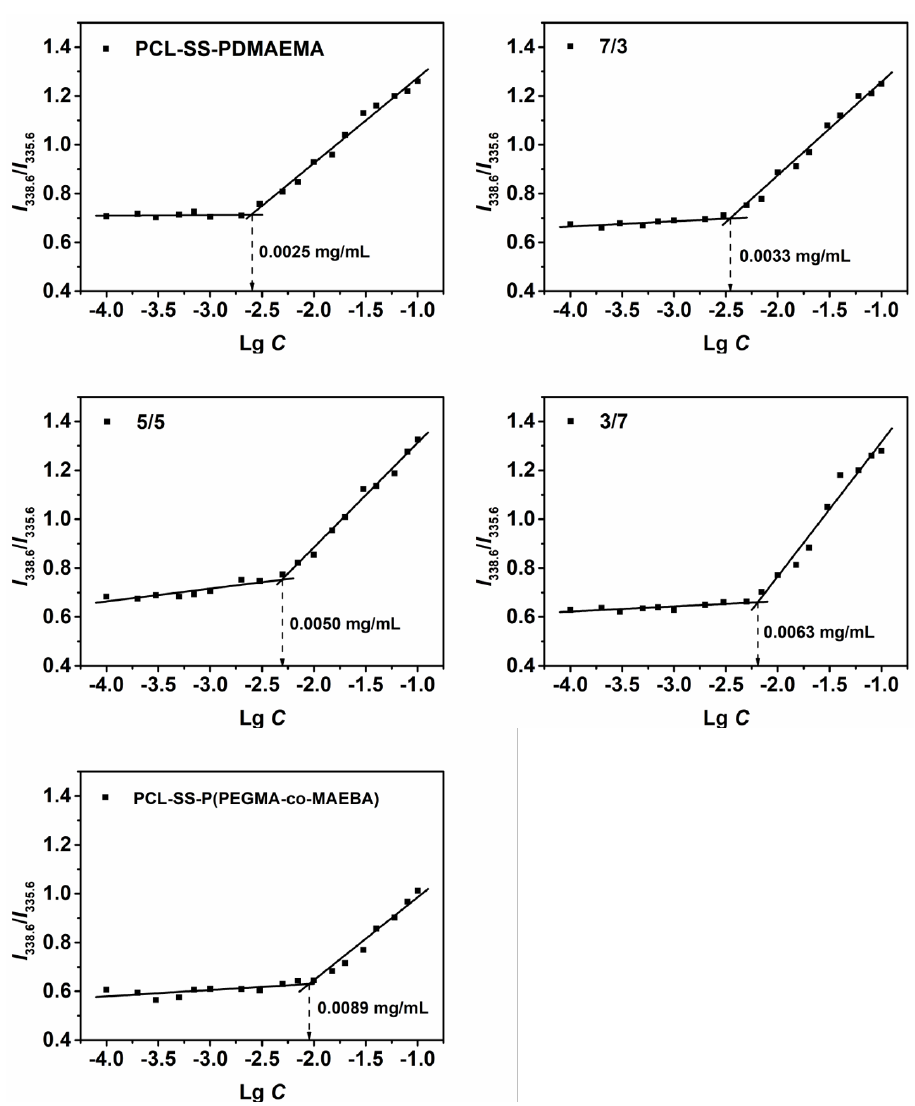
Figure 5. Graphs of intensity ratios ( I 338.6 / I 335.6 ) as functions of logarithm of copolymer mixture concentrations in aqueous solutions with different copolymeric mass ratios (PCL-SS-PDMAEMA to PCL-SS-P(PEGMA- co -MAEBA)) (The unit of C in the figures X-scale is mg/mL, and LgC is the corresponding logarithm of concentration C).